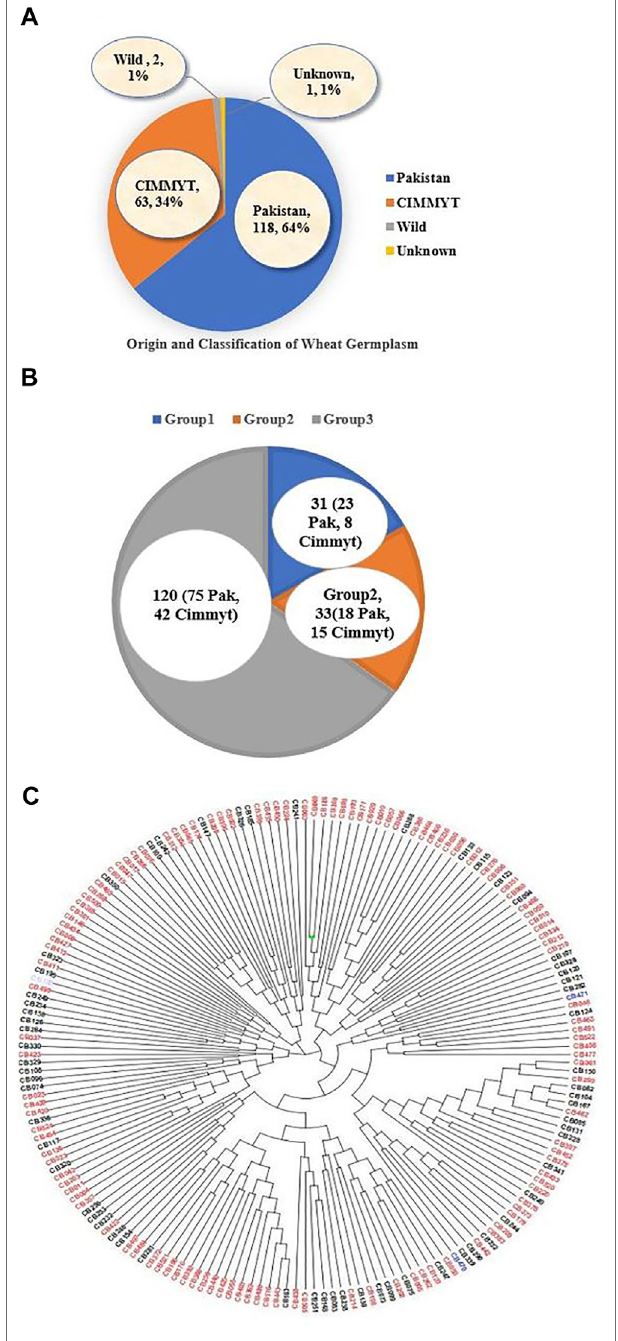
FIGURE 3 | (A) Origin of wheat accessions, (B) Classi fi cation of accessions in three different groups on the basis of structure analysis and phylogenetic tree analysis (C) Distribution of different accession in different sub-groups,theredcolorshowedlocalgenotypes,blackcolorindicated CIMMYT accessions, blue color for wild type and purple color for unknown origin.